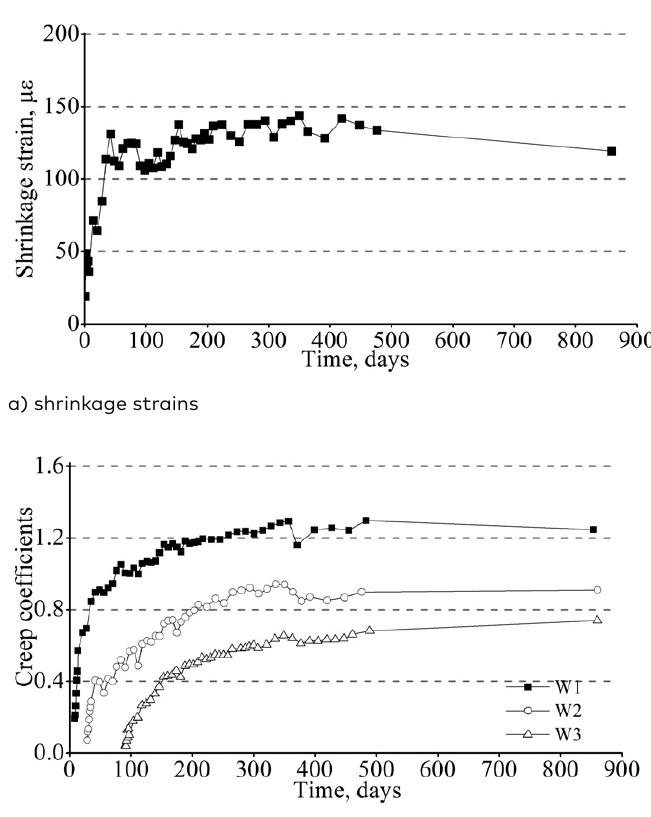
Figure 6. Shrinkage strains and creep coefficients versus